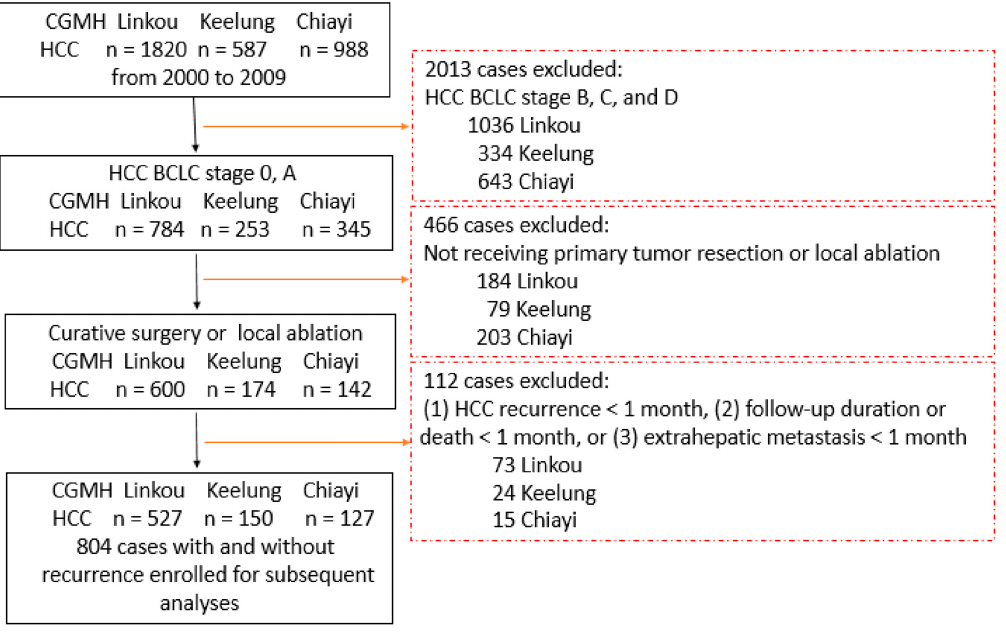
Figure 1. Flow chart of patient selection. CGMH, Chang Gung Memorial Hospital; HCC, hepatocel- lular